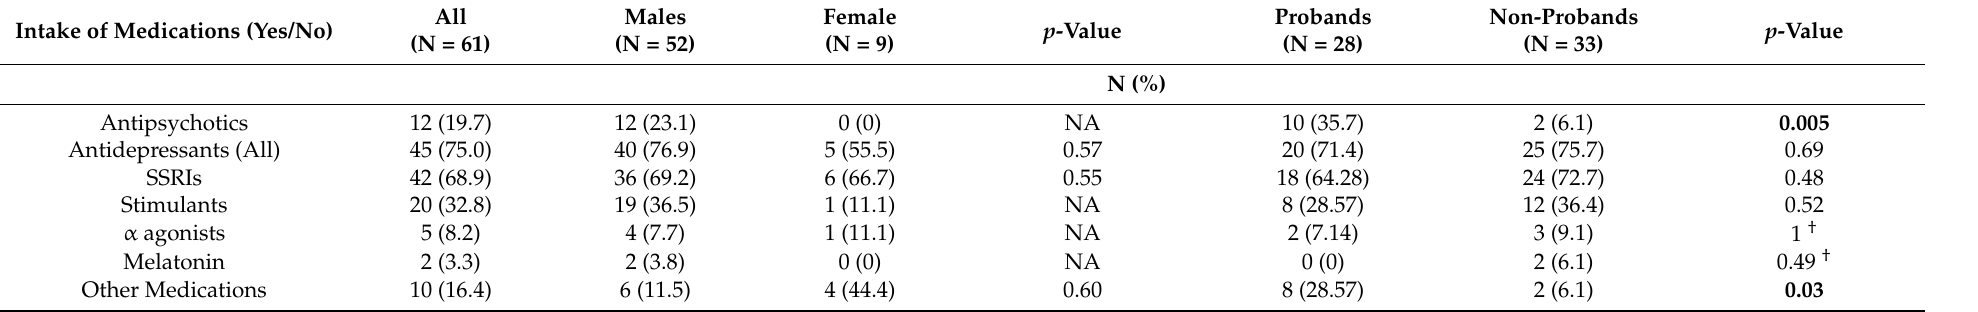
Table 4. Psychotropic medication intake in the samples of young PM